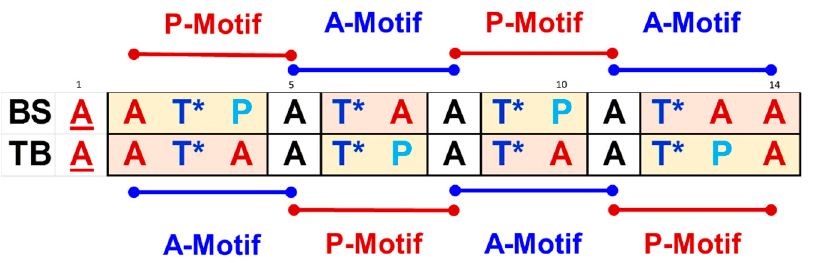
Figure 9. The primary sequence of antifreeze glycoprotein fraction 8 (AFGP8) from Boreogadus saida (BS) and Trematomus borchgrevinki (TB). The amino acid residues are color-coded as red (alanine, A), blue (glycosylated threonine, T*), and light blue (proline, P). Two consensus-repeating motifs are identified as –ATAA– (A-motif, blue horizontal lines) and –ATPA– (P-motif, red lines), with the overlapping alanine residue defined as the linker alanine residue shown in black. The second kind of alanine residue is shown in red. The linker alanine residue always precedes T*.